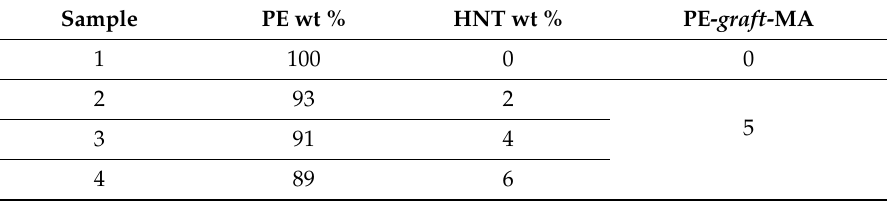
Table 1. Composition of PE / halloysite nanotube (HNT) nanocomposites.